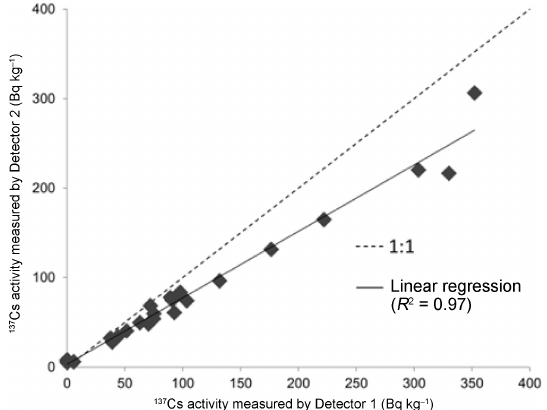
Figure 5. The comparison between the 137 Cs measurements of a subset of samples ( n = 16) performed with two different HPGe de- tectors; detector 1 is housed by the Physics Department at the Uni- versity of Basel (CH) and detector 2 is housed by the State Labora- tory Basel-City (CH).